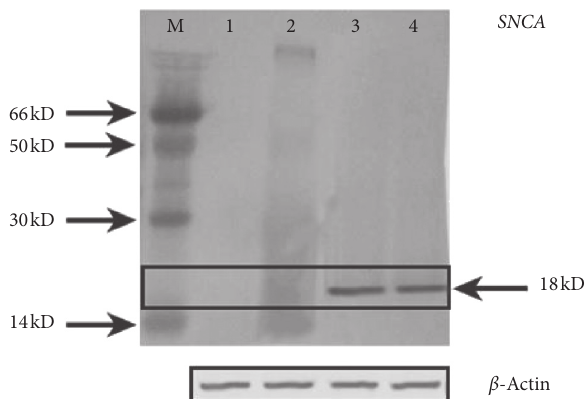
Figure 1: Human SNCA expression in the brain of transgenic flies. Western blot analyses of the human α -synuclein protein were made on the brain lysates of the flies expressing human SNCA gene via pUAST- GAL4 -mediated gene expression. Lane description: marker (M), negative control genotype, w 1118 (1), UAS-E46K/+ (2), SNCA wt /+; elav/+ (3), SNCA E46K /+; elav/+ (4). The human α -synuclein protein was detected using anti-human α -synuclein mouse IgG monoclonal antibody (Invitrogen, USA). An anti- Drosophila ß -actin antibody (Abcam) was used as a control. Gel analysis tool in ImageJ software revealed no significant difference between bands in lanes 3 and 4 ( p � 0 . 057). This indicated equal expression of wild-type and E46K mutant copy of SNCA gene in the brain of the transgenic